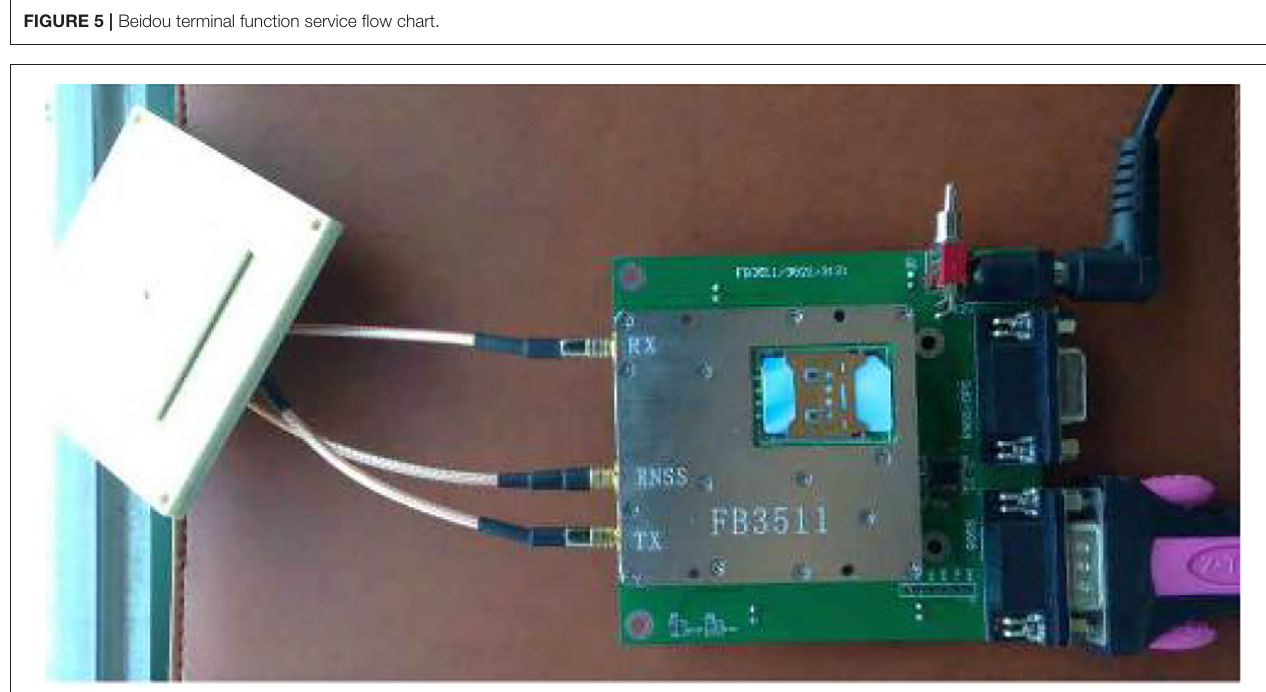
FIGURE 6 | Beidou interactive location-indicating